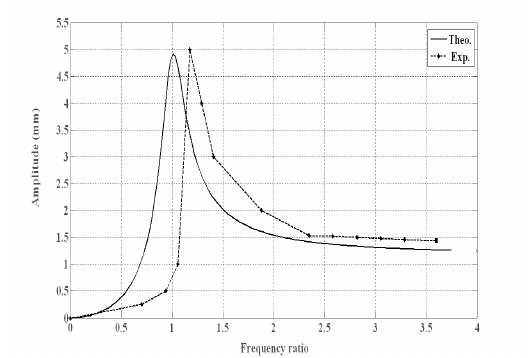
Fig. 10. Shows the varaition of the amplitude versus frequency ratio for m=0.386 kg, and e=0.12 m.